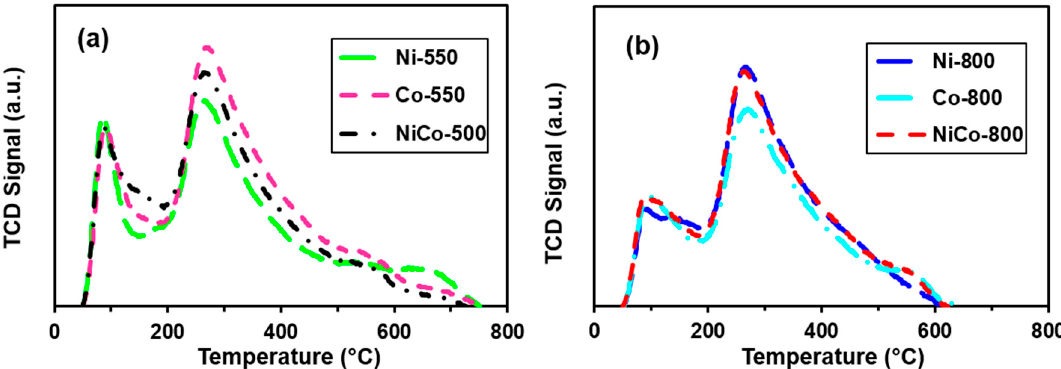
Figure 5. CO 2 -TPD profiles for fresh Ni and/or Co-based catalysts after calcination at ( a ) 550 °C and ( b ) 800 °C.